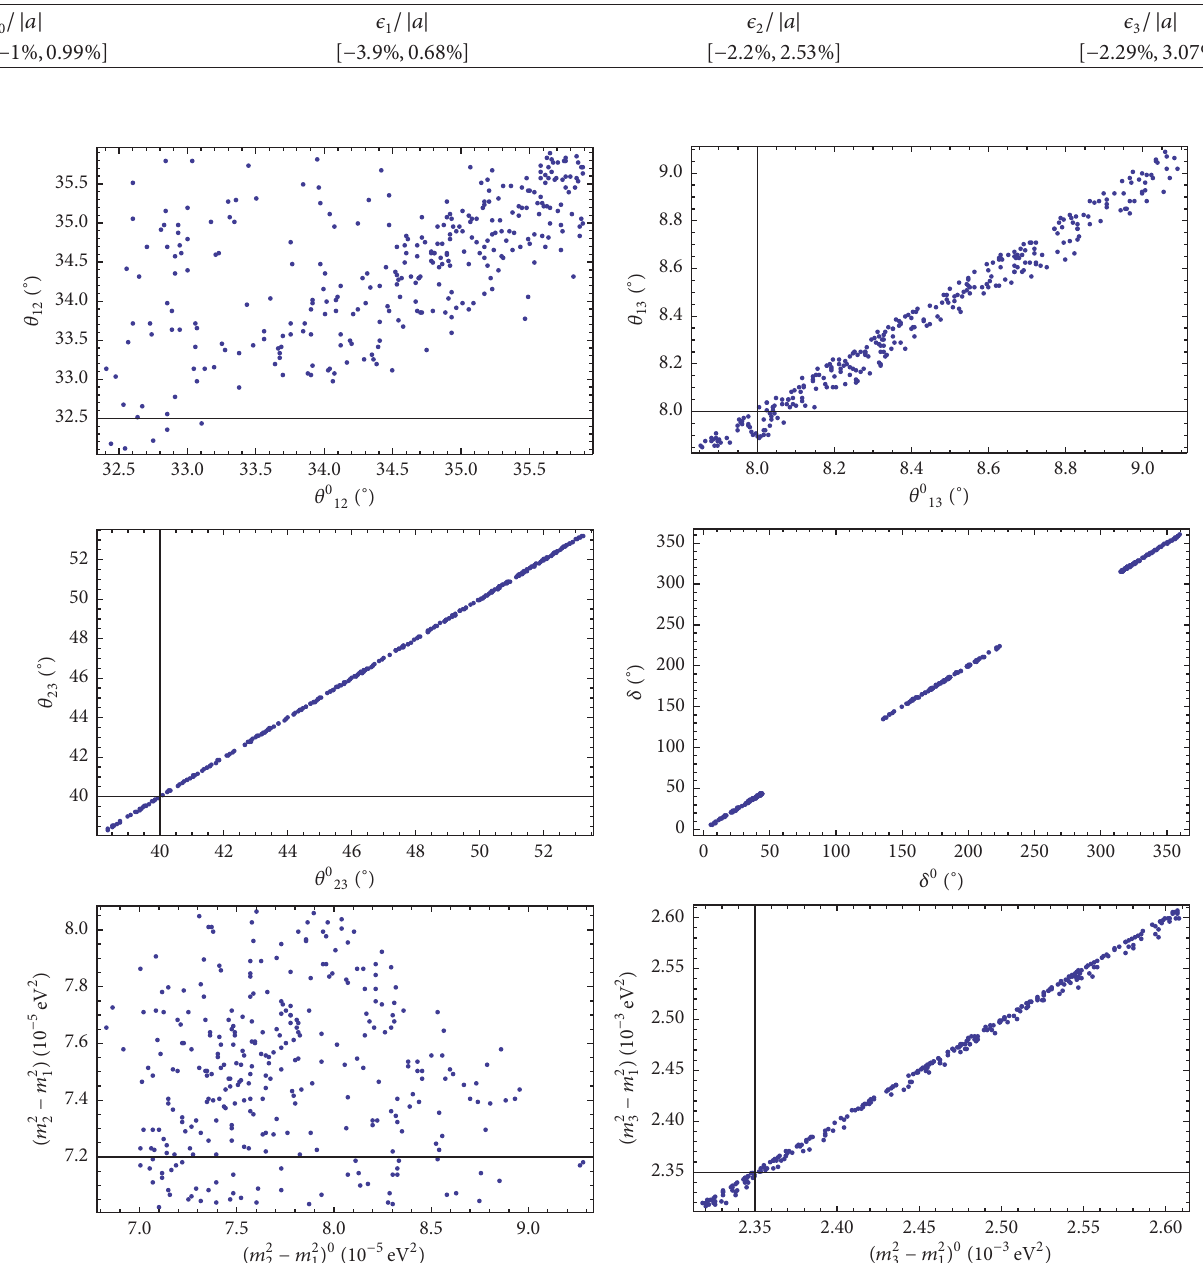
Figure 3: Correlations of neutrinos oscillation parameters before and after the perturbation with the parameter 𝜖 1